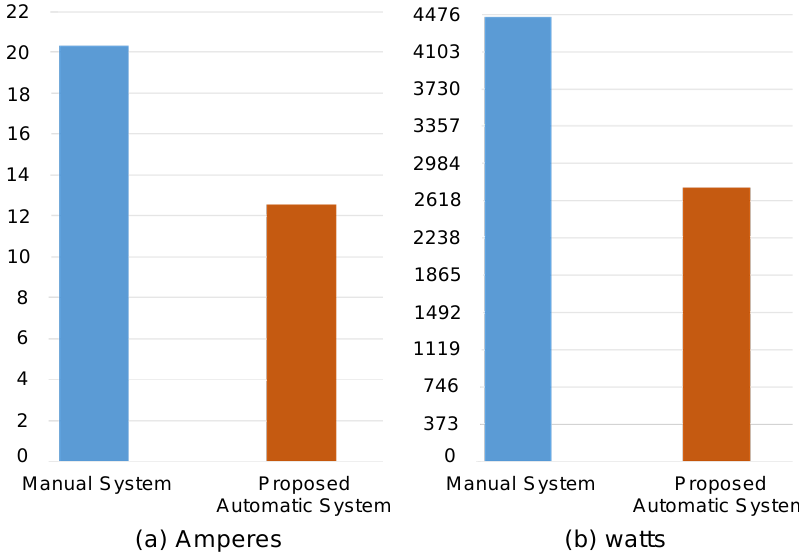
Figure 14. The average energy consumption of different home appliances in terms of ampere and watt used by the manual operated system and the proposed automatic one.